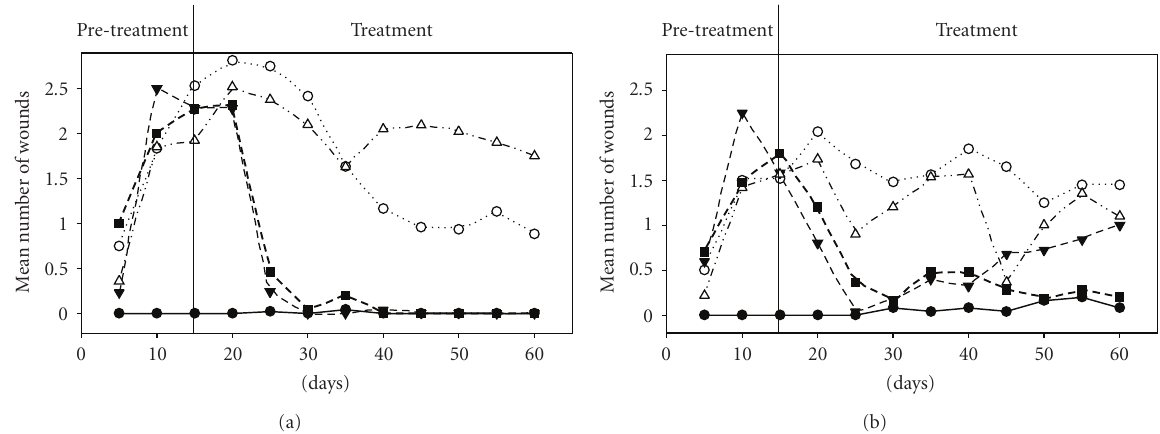
Figure 2: Mean ( n = 5) number of wounds per animal in male (a) and female (b) hamsters during the experiment. Legend as in Figure 1.